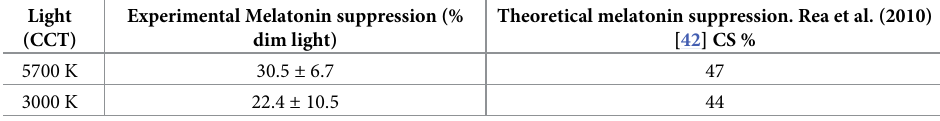
Table 1. Experimental and theoretical melatonin suppression for experimentally tested light sources.